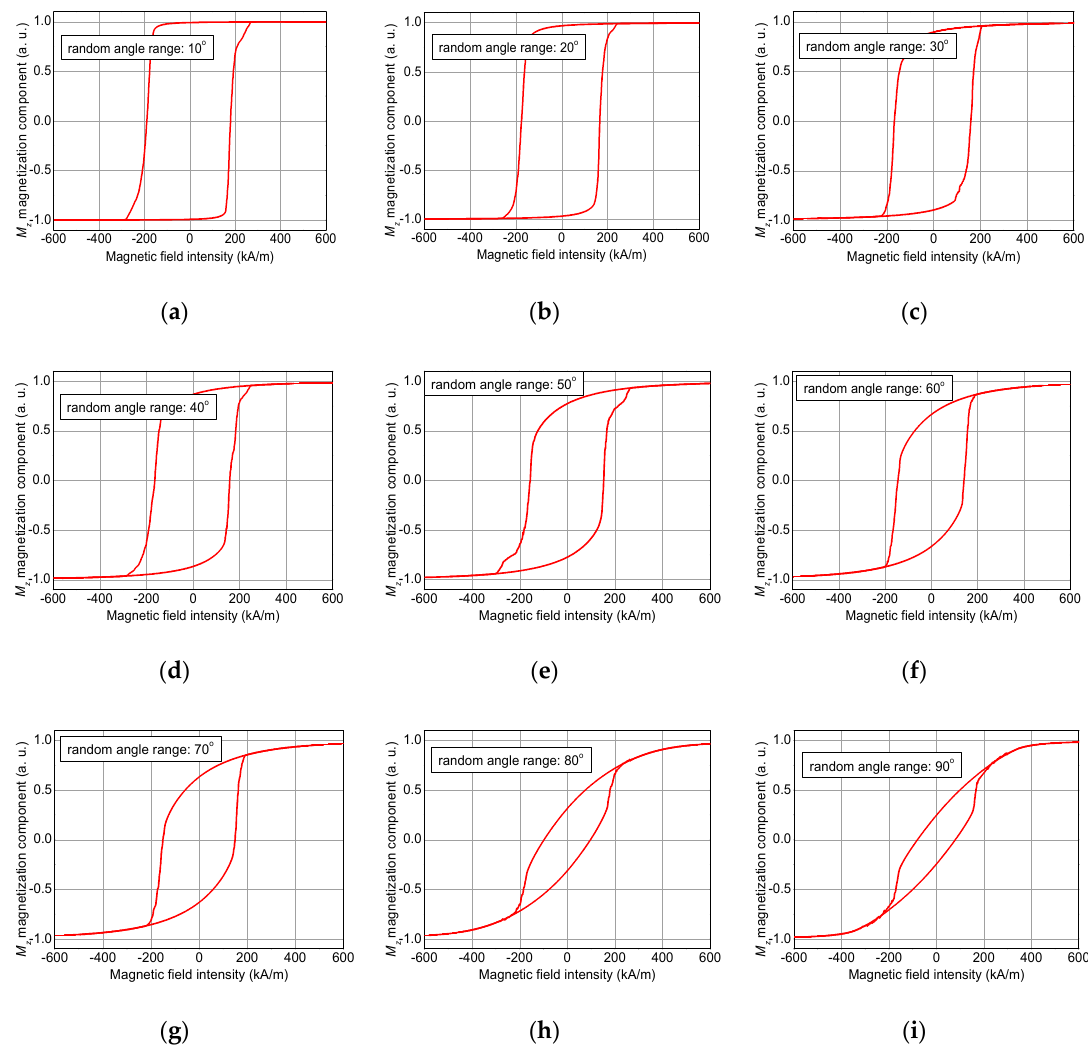
Figure 15. Hysteresis loops, simulated for an external magnetic field sweep along the z-axis and random angle ranges, depicted in steps of 10°: ( a ) 10°, ( b ) 20°, ( c ) 30°, ( d ) 40°, ( e ) 50°, ( f ) 60°, ( g ) 70°, ( h ) 80°, and ( i ) 90°.